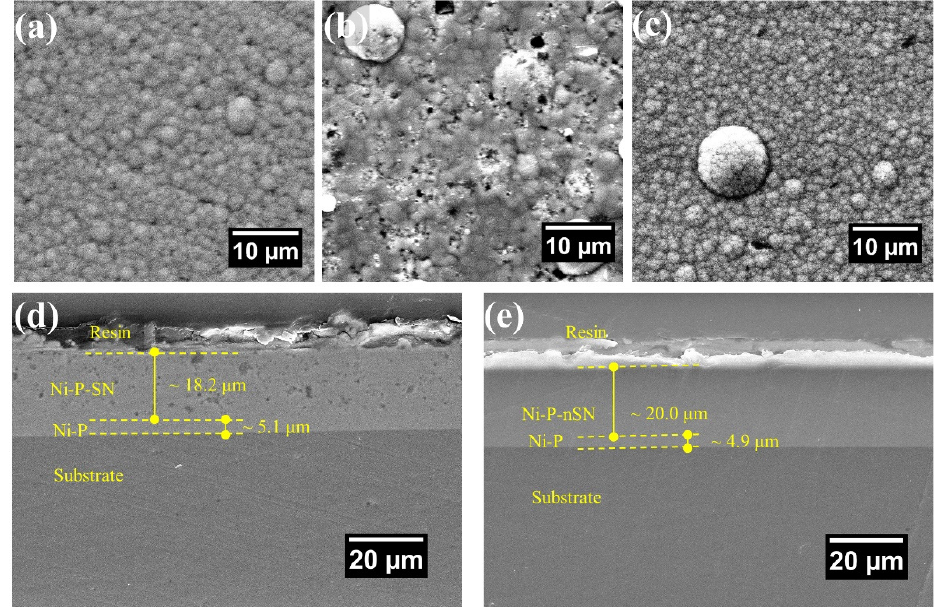
Figure 1. Surface morphology of ( a ) Ni-P, ( b ) Ni-P-SN, and ( c ) Ni-P-nSN composite coatings. The cross-sectional view of the Ni-P-SN and Ni-P-nSN composite coatings are, respectively, shown in ( d , e ). Both Ni-P-SN and Ni-P-nSN consist of a layer (~5 µm) of Ni-P alloy as the Si 3 N 4 particles were added to the bath after 10 min of Ni-P prior coating.